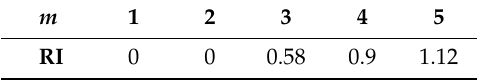
Table 3. Average of the consistency indices (RI) from randomly generated matrices.